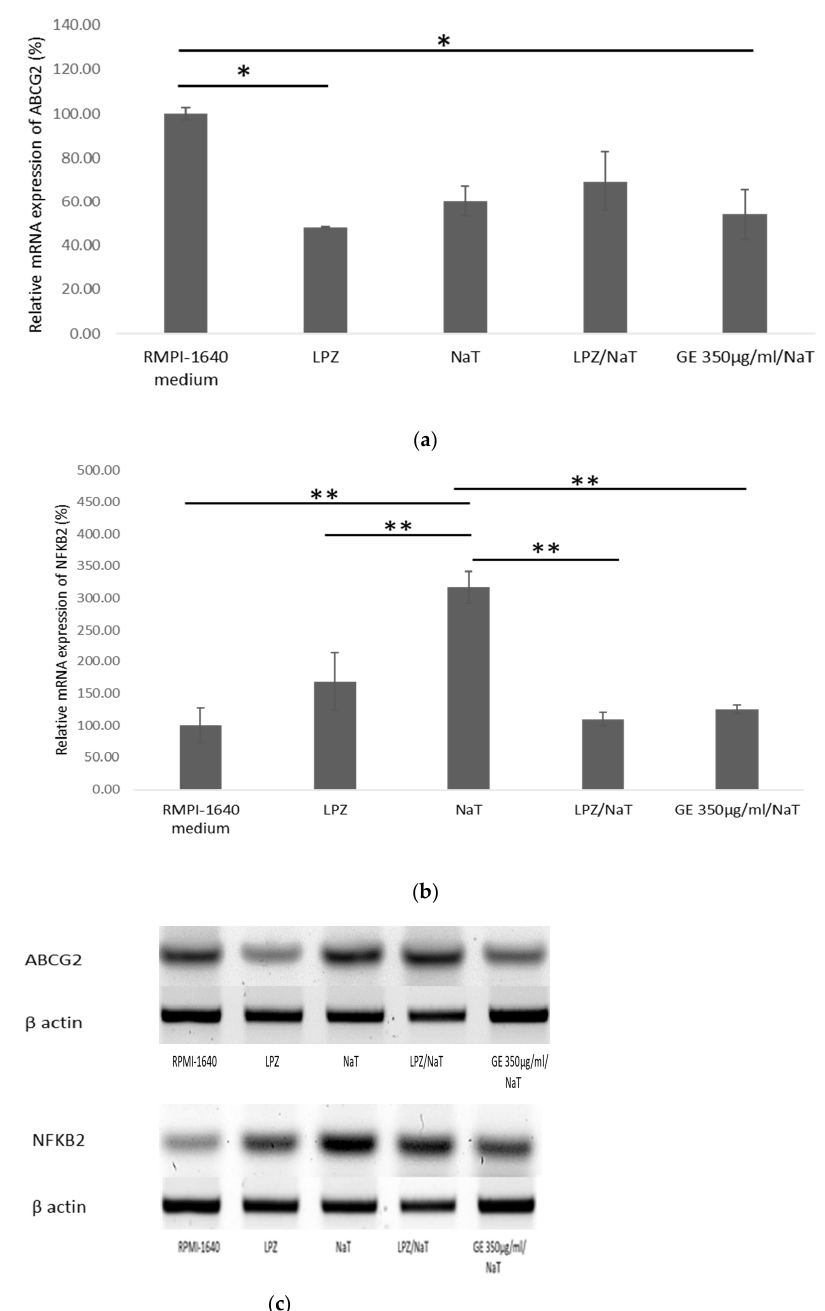
Figure 6. Expression of ABCG2 and NFKB2 in cell culture model of peptic ulcer disease. ( a ) ABCG2 gene expression in AGS treated cell line. One-way ANOVA F(4,14) = 5.683 p = 0.01191; post hoc Tukey HSD test; * p < 0.05. The gene expression analysis was carried out by RT-PCR and ob- tained results were semi-quantified ImageJ software using QuantIF ImageJ macro. The values are represented as means ±SD. The data shown are representative of three independent experiments. ATP-binding cassette sub-family G, member 2 (ABCG2). ( b ) NFKB2 gene expression in AGS treated cell line. One-way ANOVA F (4,14) = 11.61, p = 0.0008926; post hoc Tukey HSD test; ** p < 0.01. The gene expression analysis was done by RT-PCR and obtained results were semi-quanti- fied by ImageJ software using QuantIF ImageJ macro. The values are represented as means ± SD. The data shown are representative of three independent experiments. Nuclear Factor Kappa B Subunit 2 (NFKB2). ( c ) Representative figures of Southern blot analysis of ABCG2 and NFKB2 expression compared to β actin expression.